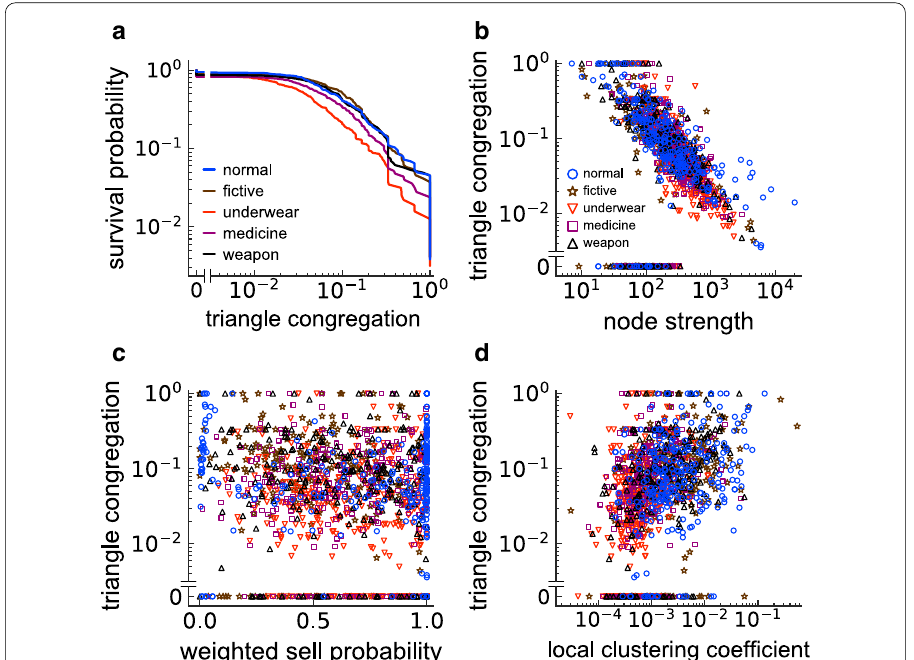
Fig. 7 Triangle congregation for each user type. a Survival probability. b Relationship between the triangle congregation, m i , and the node strength. c Relationship between m i and the weighted sell probability. d